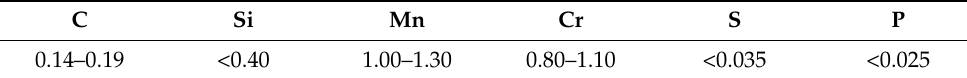
Table 2. Chemical composition of the material 16MnCr5 (DIN EN 10184:2008).